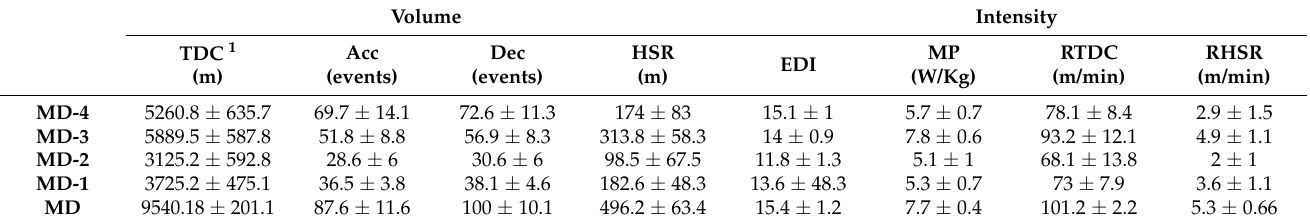
Table 2. Basic descriptors (mean and standard deviation) for each variable according to the day before match.